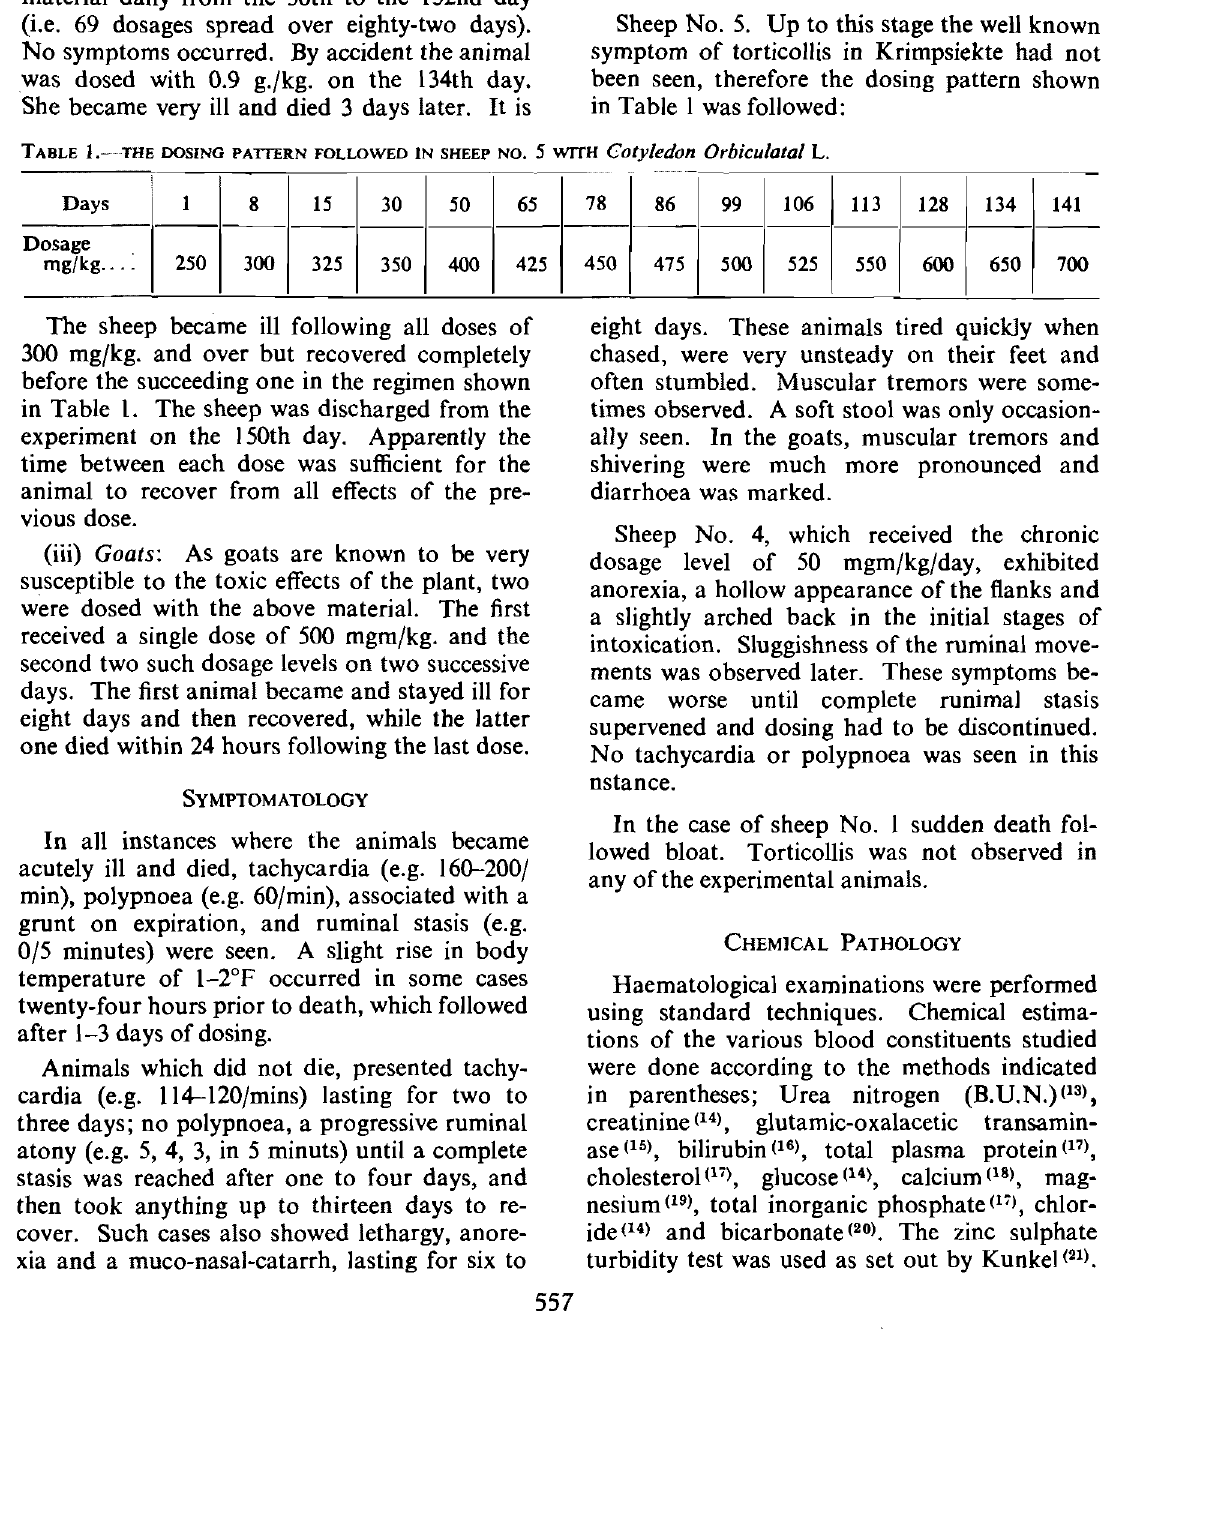
TABLE 1.- THE DOSING PAlTERN FOLLOWED IN SHEEP No.5 WITH Cotyledon Orbiculatal